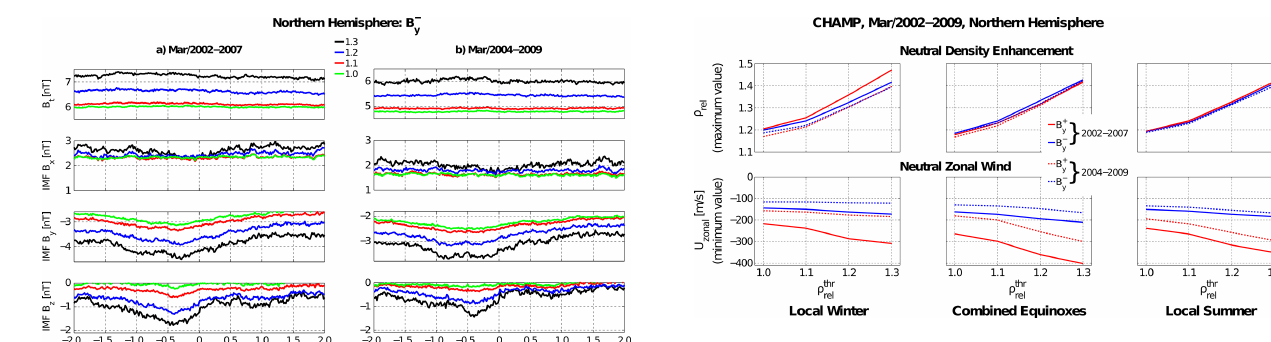
Fig. 8. The peak amplitudes of (from left to right) ρ rel and U zonal for different levels of ρ thr and for local winter, combined equinoxes, rel and local summer. The results are shown for IMF B + y (red) and B − y (blue) for two periods: March 2002–March 2007 (solid line) and March 2004–March 2009 (dashed